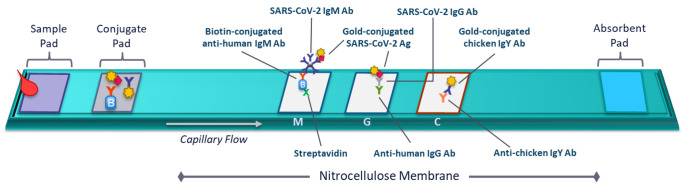
Schematic of Easy Check COVID-19 IgM/IgGTM lateral flow assay.